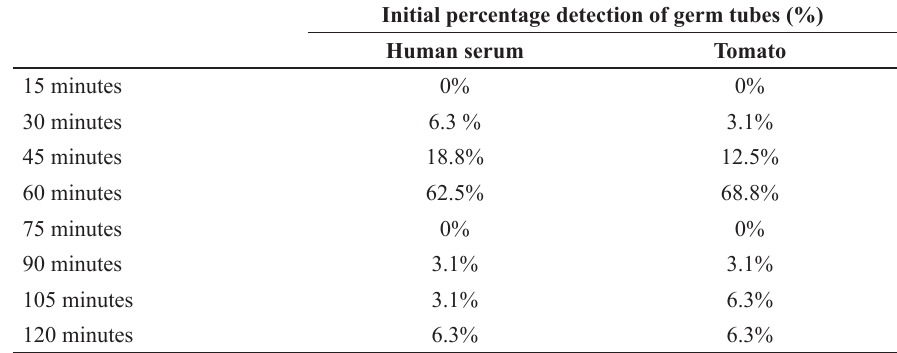
Table 2: Intra species variation in germ tube production of C. albicans in human serum and tomato